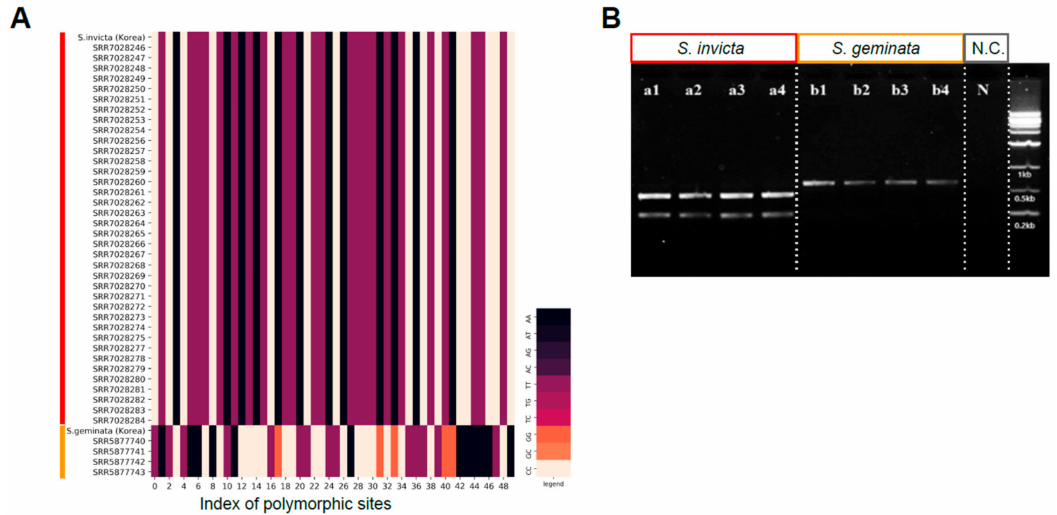
Figure 4. Classification using the key sites in COX1 gene for S. invicta and S. geminata . ( A ) Haplotypes for the key sites in COX1 for Solenopsis samples used in this study. ( B ) Evaluation of the cleaved amplified polymorphic sequences (CAPS) marker designed using the key sites in COX1 gene. The restriction enzyme BspHI cuts PCR fragment of S. invicta into two fragments of the predicted size (441 and 190 bp), whereas S . geminata shows the undigested PCR product (631 bp).